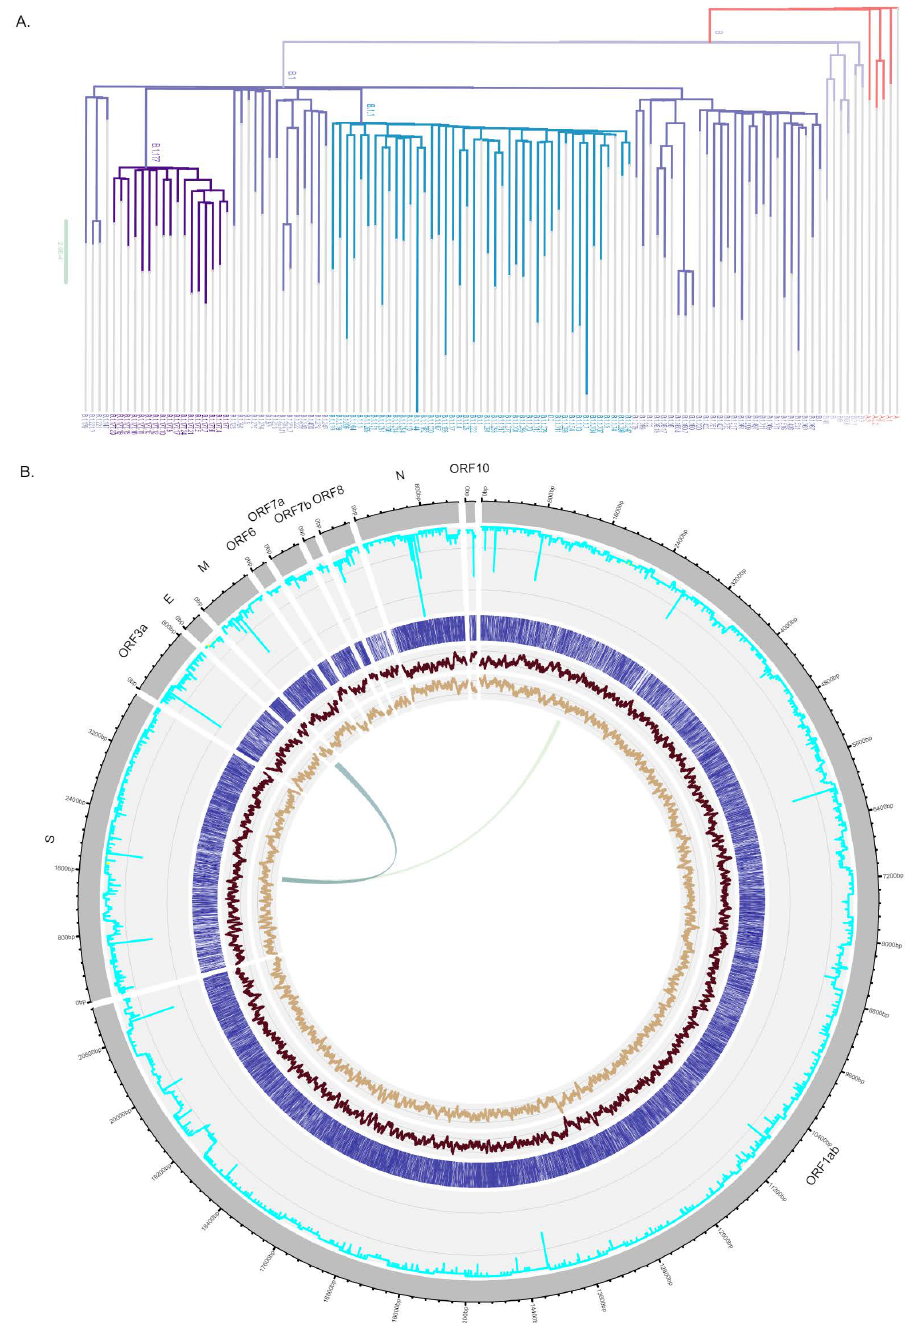
Figure 1. Genetic diversity of SARS-CoV-2. ( A ) Maximum likelihood phylogeny of SARS-CoV- 2 genomes including one representative sequences from the 116 most common lineages globally sampled in the GISAID database on 15 March 2021. Lineage A and descendants were colored in red, and purple was used for lineage B and descendent. Within B, the B.1.1 and B.1.177 were colored in blue and dark purple, respectively. ( B ) Circular visualization of SARS-CoV-2 genome showing the genes in grey in the outer ring. Other tracks contain (from the outside in): the sequence identity line plot (cyan) across 116 genomes from the most common SARS-CoV-2 lineages; a bar plot indicating in blue the residues that are identical when comparing SARS-CoV-2 vs. SARS-CoV; line plots showing the AT (dark brown) and GC (light brown) contents of the SARS-CoV-2 genomes. Connecting ribbons in the center of the plot indicate the regions where the three sets of oligonucleotides from the reported assay were designed. NC_045512.2 was the reference